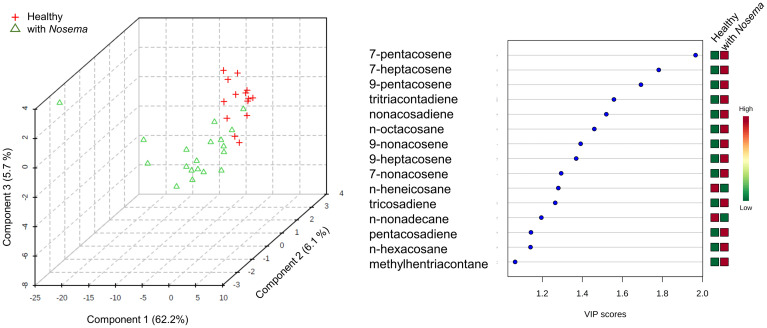
Multivariate analysis of CHC from healthy and Nosema-infected honeybees: 3-D scores plot (A) between selected components corresponding to a PLAS-DA run on samples form healthy and Nosema–infected bees. The explained variances are shown in brackets. The model was validated (number of components needed, 5; performance: R2 = 0.81; Q2 = 0.32, permutation test p = 0.002). Important features (VIP > 1) found by PLS-DA (B): colored boxes on the right indicate the relative concentrations of the corresponding metabolite in each group under study.